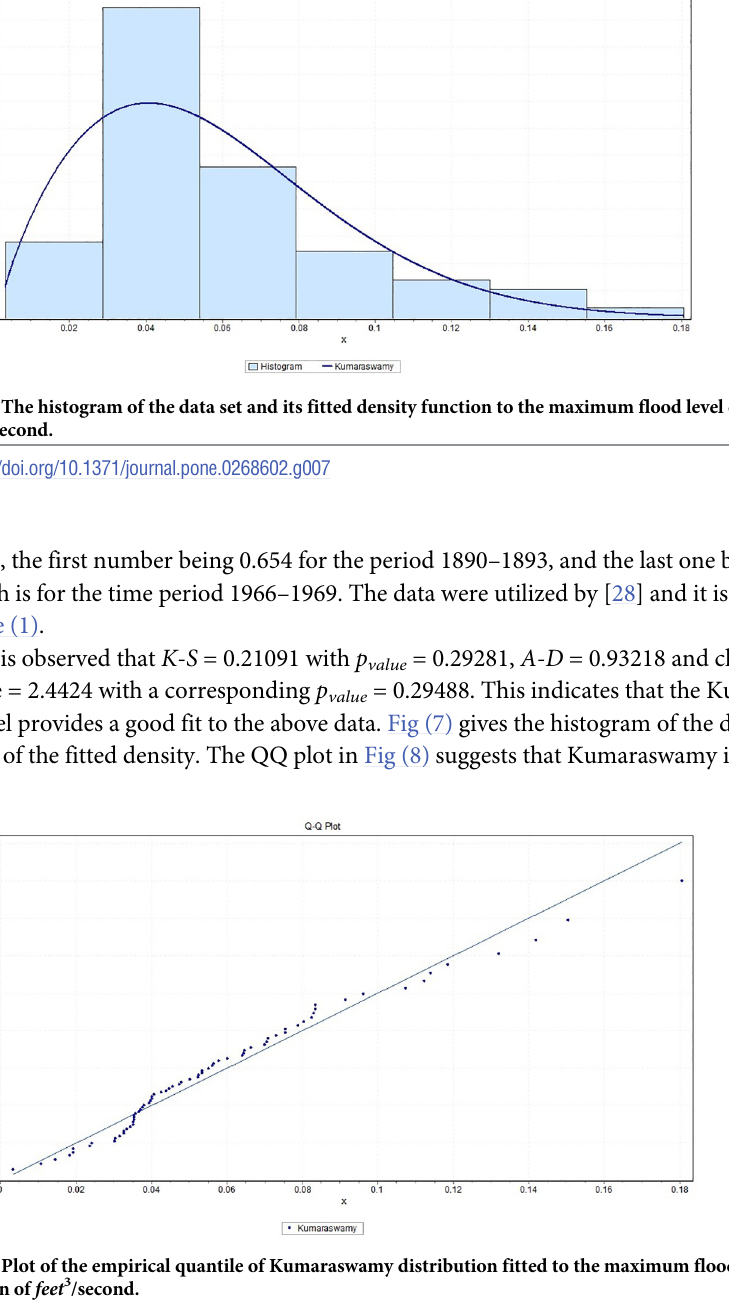
Fig 8. Plot of the empirical quantile of Kumaraswamy distribution fitted to the maximum flood level data in million of feet 3 /second.